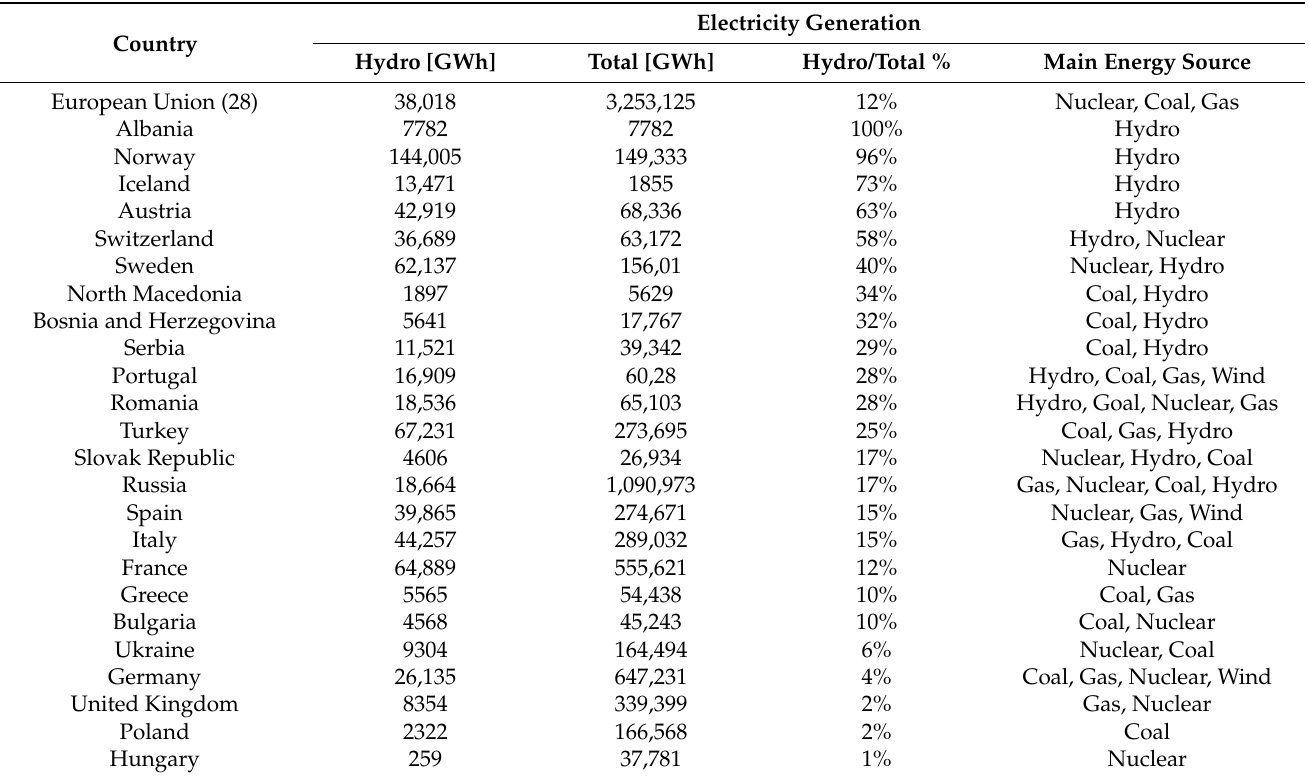
Table 4. Ranking of European Countries by hydro percentage in total energy production. Source of data: IHA 2018.